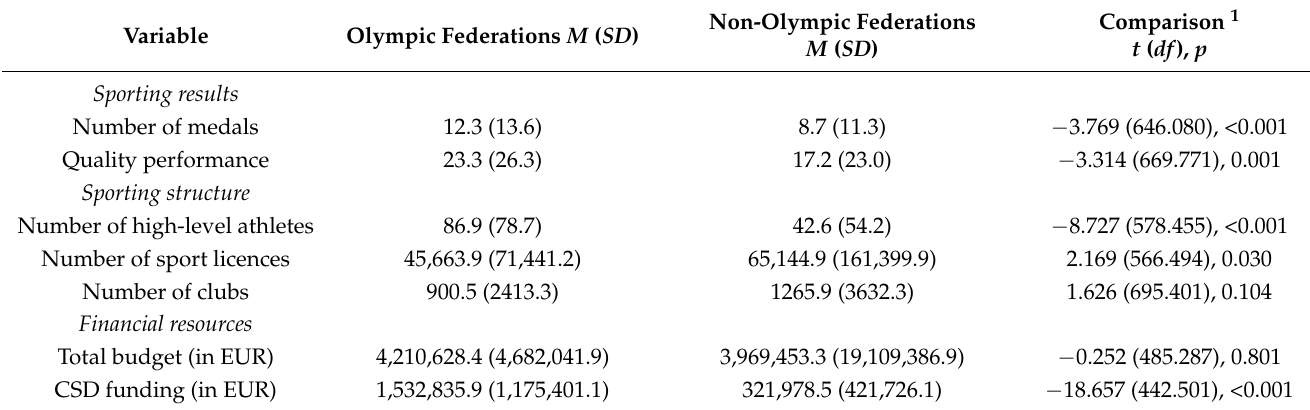
Table 3. Comparison between Olympic and non-Olympic sport federations.